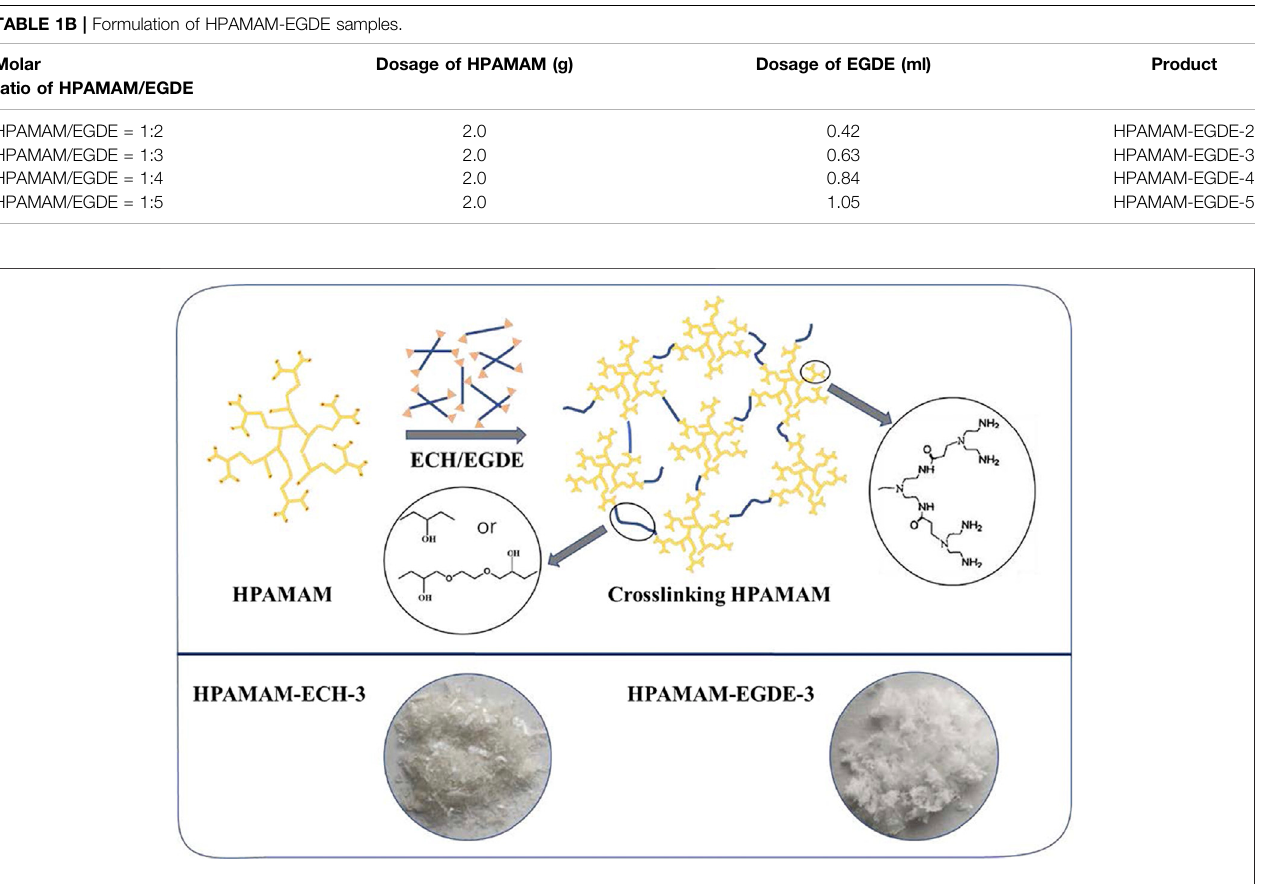
SCHEME 1 | Schematic diagram of the crosslinking